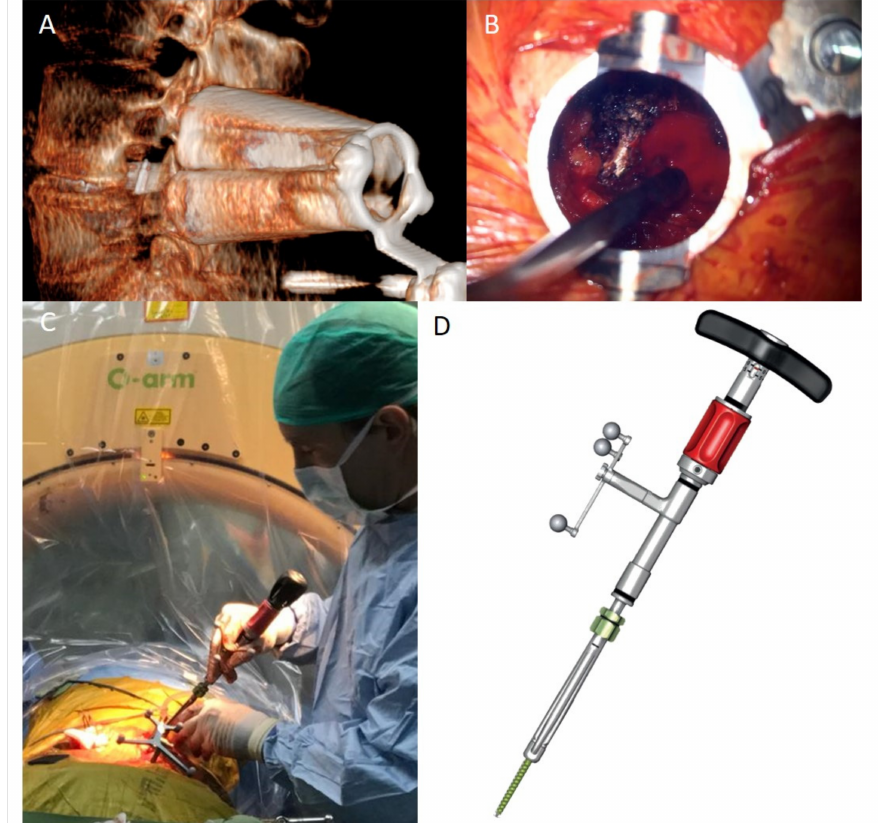
Figure 1. Expendable MIS retractor is positioned over the lamina and facet joint of the index vertebra allowing for a transpedicular approach to the vertebral body and partial corpectomy, thus decompressing the thecal sac and nerve roots (( A ) 3D reconstruction of intraoperative O-arm images ( B )); following decompression, one-step screws (Viper-Prime FNS, J&J, NJ, USA) are fitted with a Sure-trak reference frame (Medtronic, MN, USA, ( D )) and calibrated. Following skin incision, the screws are advanced to the starting point with navigation guidance. The k-wire was advanced 2–3 mm, and a malate was used to anchor the screw. The screw handle was used to advance the screw with navigation guidance ( C